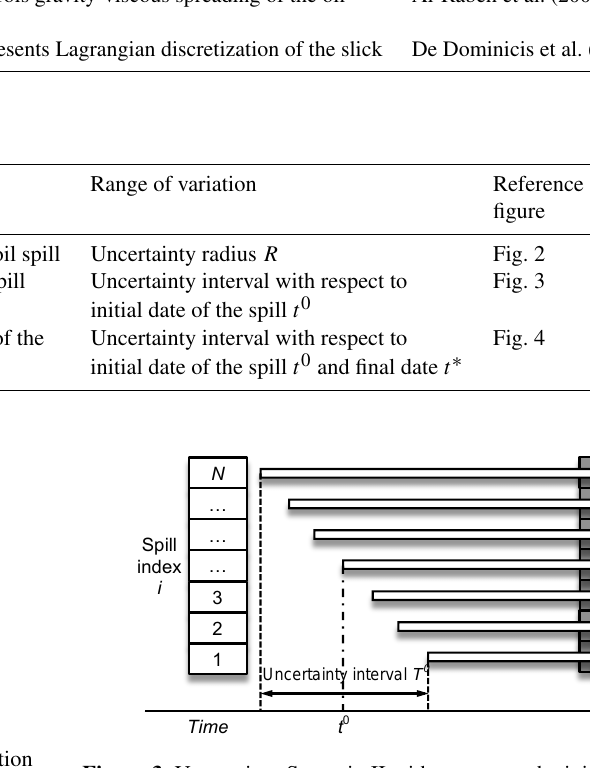
Figure 3. Uncertainty Scenario II with respect to the initial date of the oil